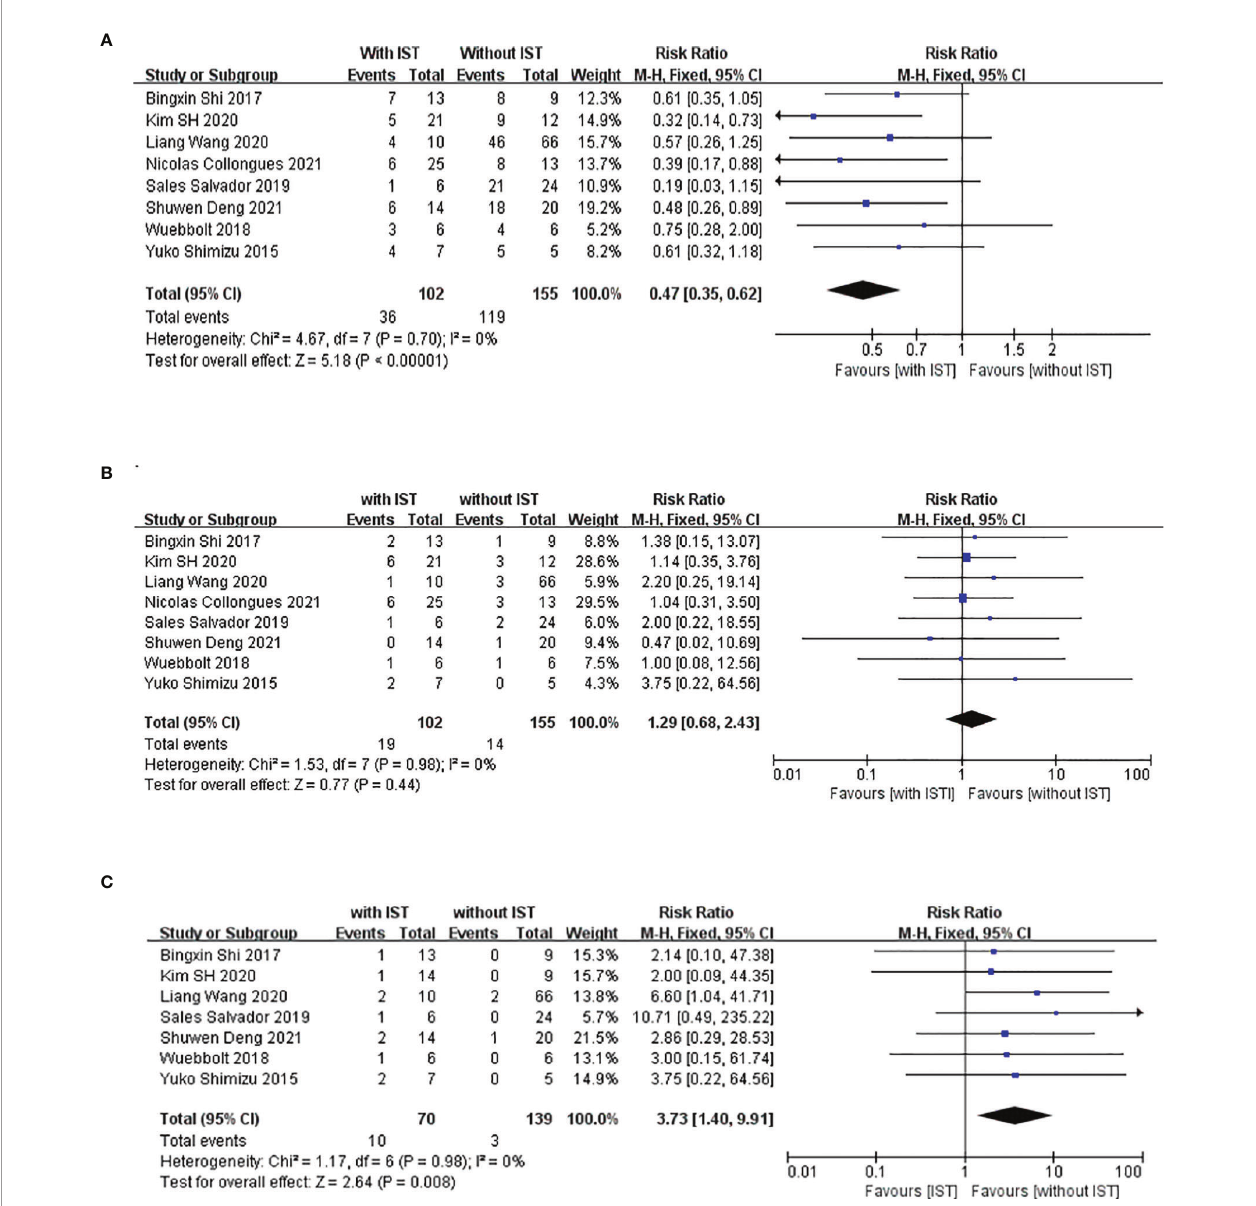
FIGURE 3 | Meta-analysis of immune-suppression treatment during pregnancy and relapse rate (RR), incidence of unhealthy neonates, and miscarriage. This fi gure presents a meta-analysis of 8 studies (including our study) of the association between maintenance immunosuppression treatment during pregnancy and RR (A) , miscarriage rate (B) and incidence of unhealthy neonates (C)